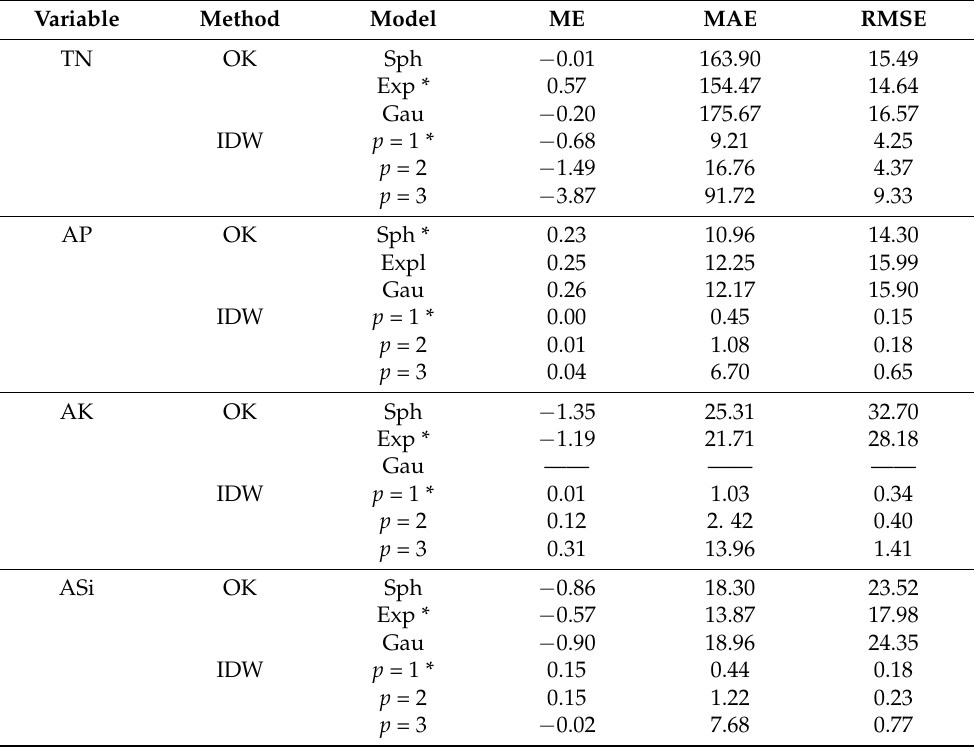
Table 4. Modeling precision of OK and IDW methods for N, P, K and Si in